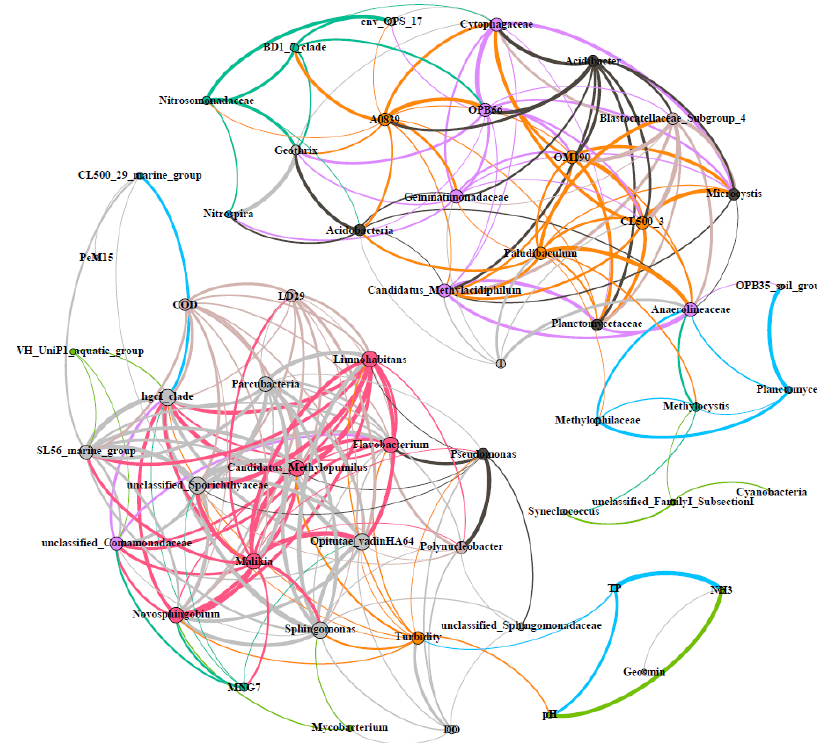
Figure 6. Network analysis of co-occurring bacterial genera and environmental parameters (the size of nodes is proportional to the number of connections, whereas the edges between two nodes are proportional to the value of Spearman’s correlation coefficients).